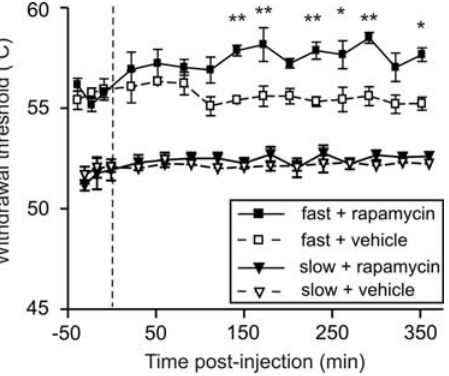
Figure 5. Rapamycin increases A- but not C- nociceptor-evoked paw withdrawal thresholds. Time-course effects of rapamycin or appropriate vehicle, on paw withdrawal thresholds to fast and slow heat ramps that preferentially activate A- and C- nociceptors respectively. N= 3 in each group. Mean 6 SEM heat withdrawal threshold ( u C) for the injected hindpaw is illustrated in each panel. Vertical dashed line indicates the drug injection time. * P , 0.05; ** P ,